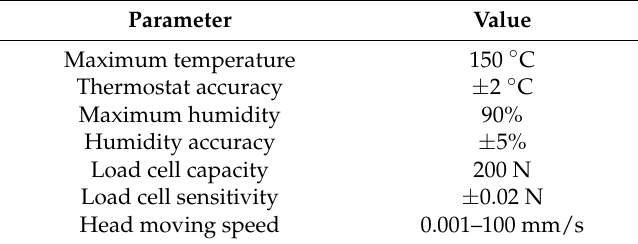
Figure 1. Material tester BS-205 with an environmental chamber. Table 2. Specification of material tester BS-205 with an environmental